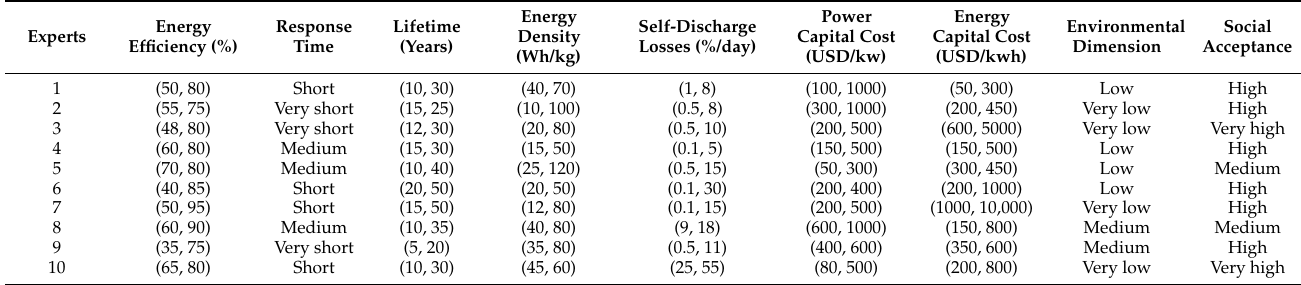
Table 4. Demand evaluation information of experts.